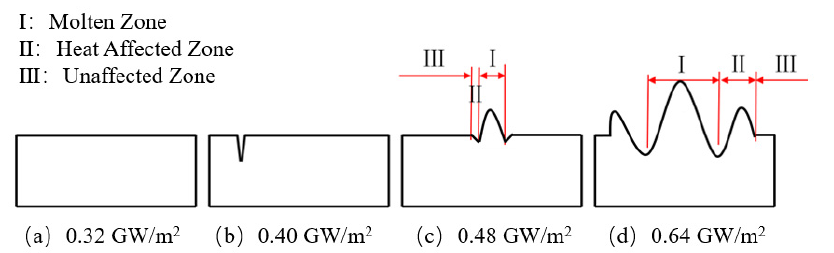
Figure 9. The schematic diagram of the damage with different power densities: ( a ) 0.32 GW/m 2 ; ( b ) 0.40 GW/m 2 ; ( c ) 0.48 GW/m 2 ; ( d ) 0.64 GW/m 2 .